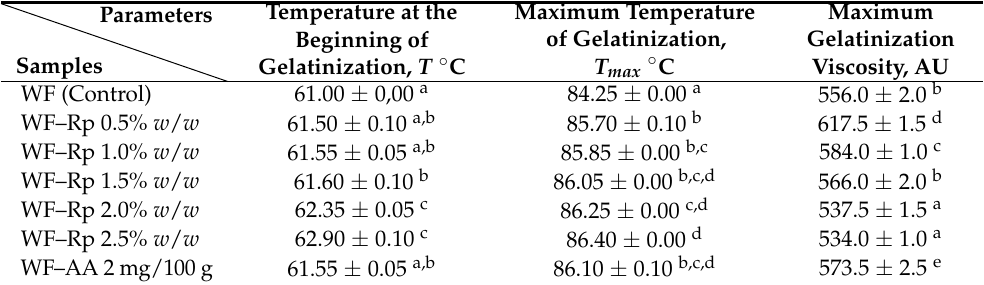
Table 1. Amylographic parameters of dough obtained from flour mixtures WF-Rp. Maximum Temperature Maximum SamplesParameters Temperature at the of Gelatinization, Gelatinization Beginning of T max ◦ C Viscosity, AU Gelatinization, T ◦ C WF (Control) 61.00 ± 0,00